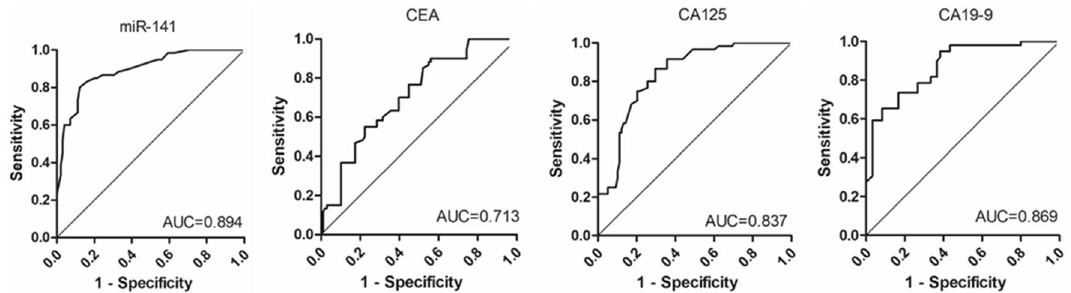
Figure 3. Comparison of the receiver operating characteristic (ROC) curves for miR-141 in the plasma and the conventional tumor biomarkers, carcinoembryonic antigen (CEA), carbohydrate antigen 125 (CA125) and